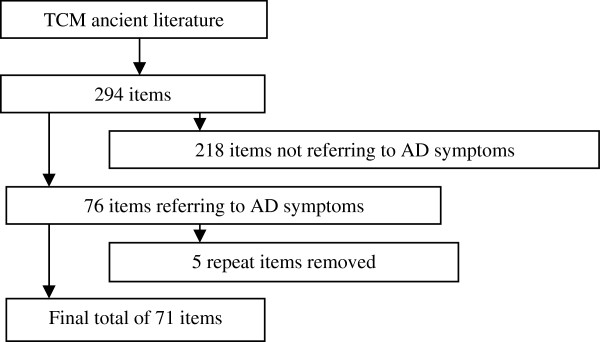
Ancient literature search process.